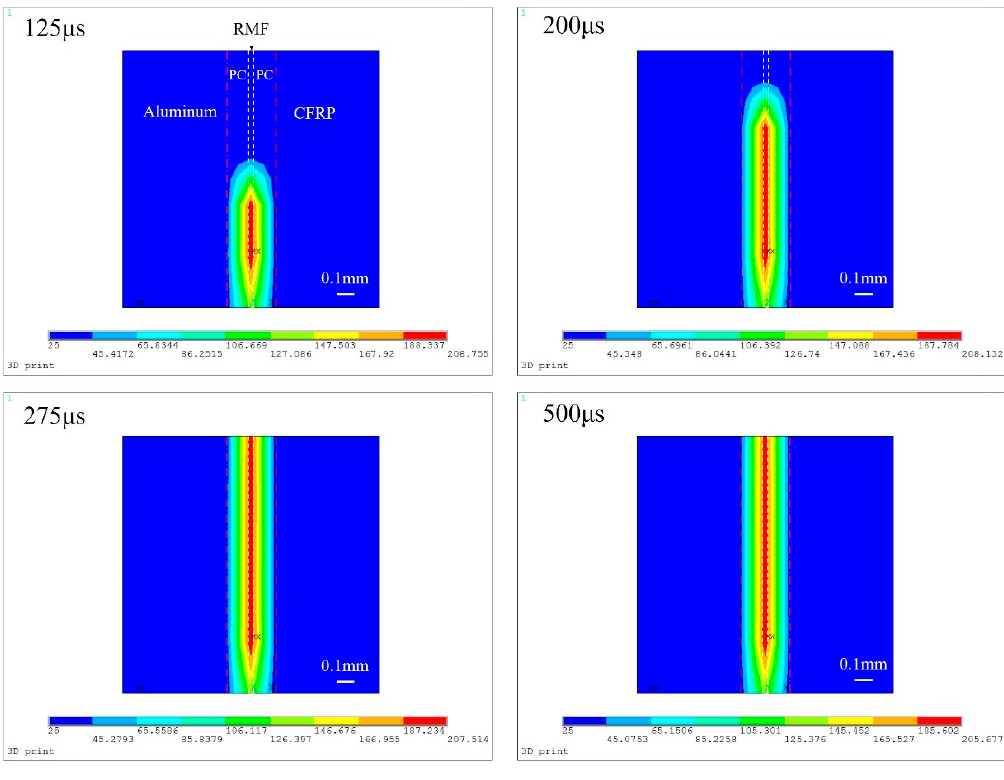
Figure 6. ANSYS simulation of the temperature evolution and distribution in the joint at various time steps.